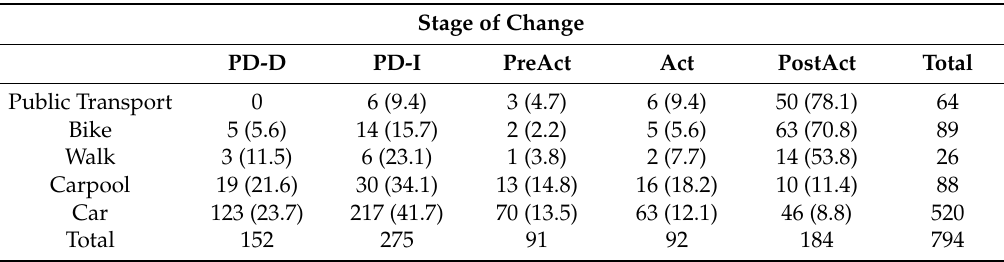
Table 3. Frequencies and percentages (in brackets) of the main travel mode use across the stages of intention to change. Stage of Change PD-D